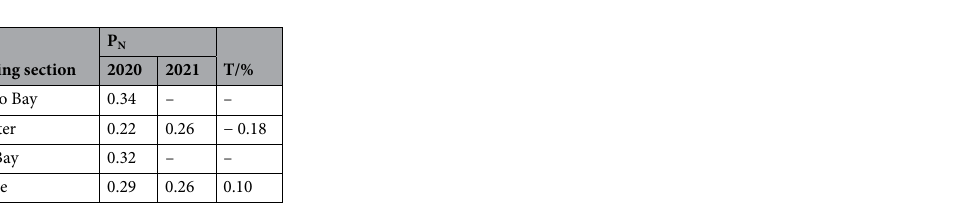
Table 8. Temporal and spatial changes of water quality in each monitoring section of Lugu Lake from 2020 to 2021.